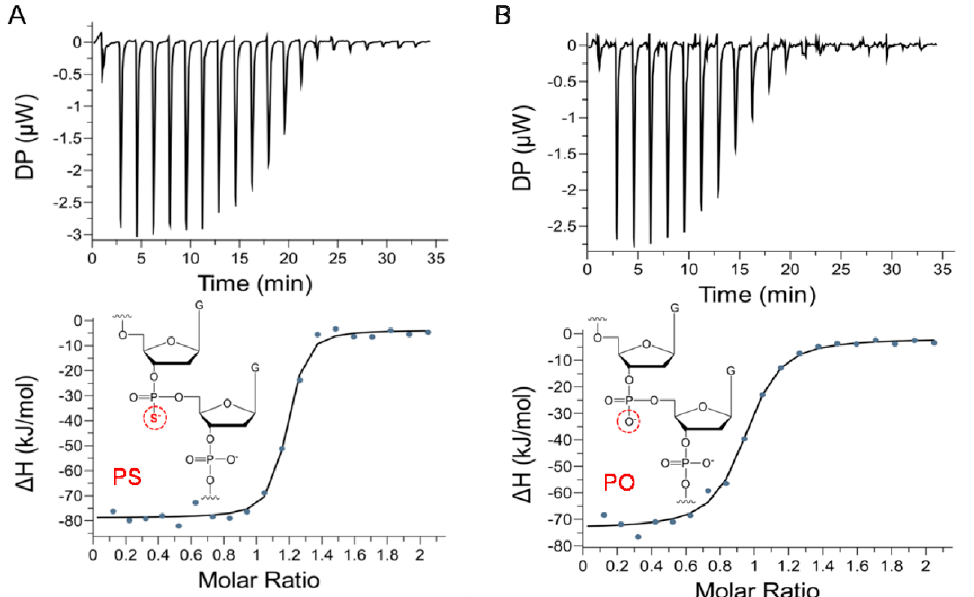
Figure 4. ITC analysis of aptamers ( A ) CBA15-G3S and ( B ) CBA15 with Cd 2+ . The top graph shows raw data for ITC titration, and the bottom graph displays the binding curve obtained by integrating the heats of each spike. The difference between PS modification and the phosphate (PO) group in the backbone of the aptamer is shown.